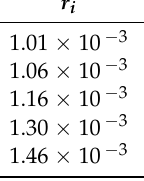
Table 3. Predicted values through exponential